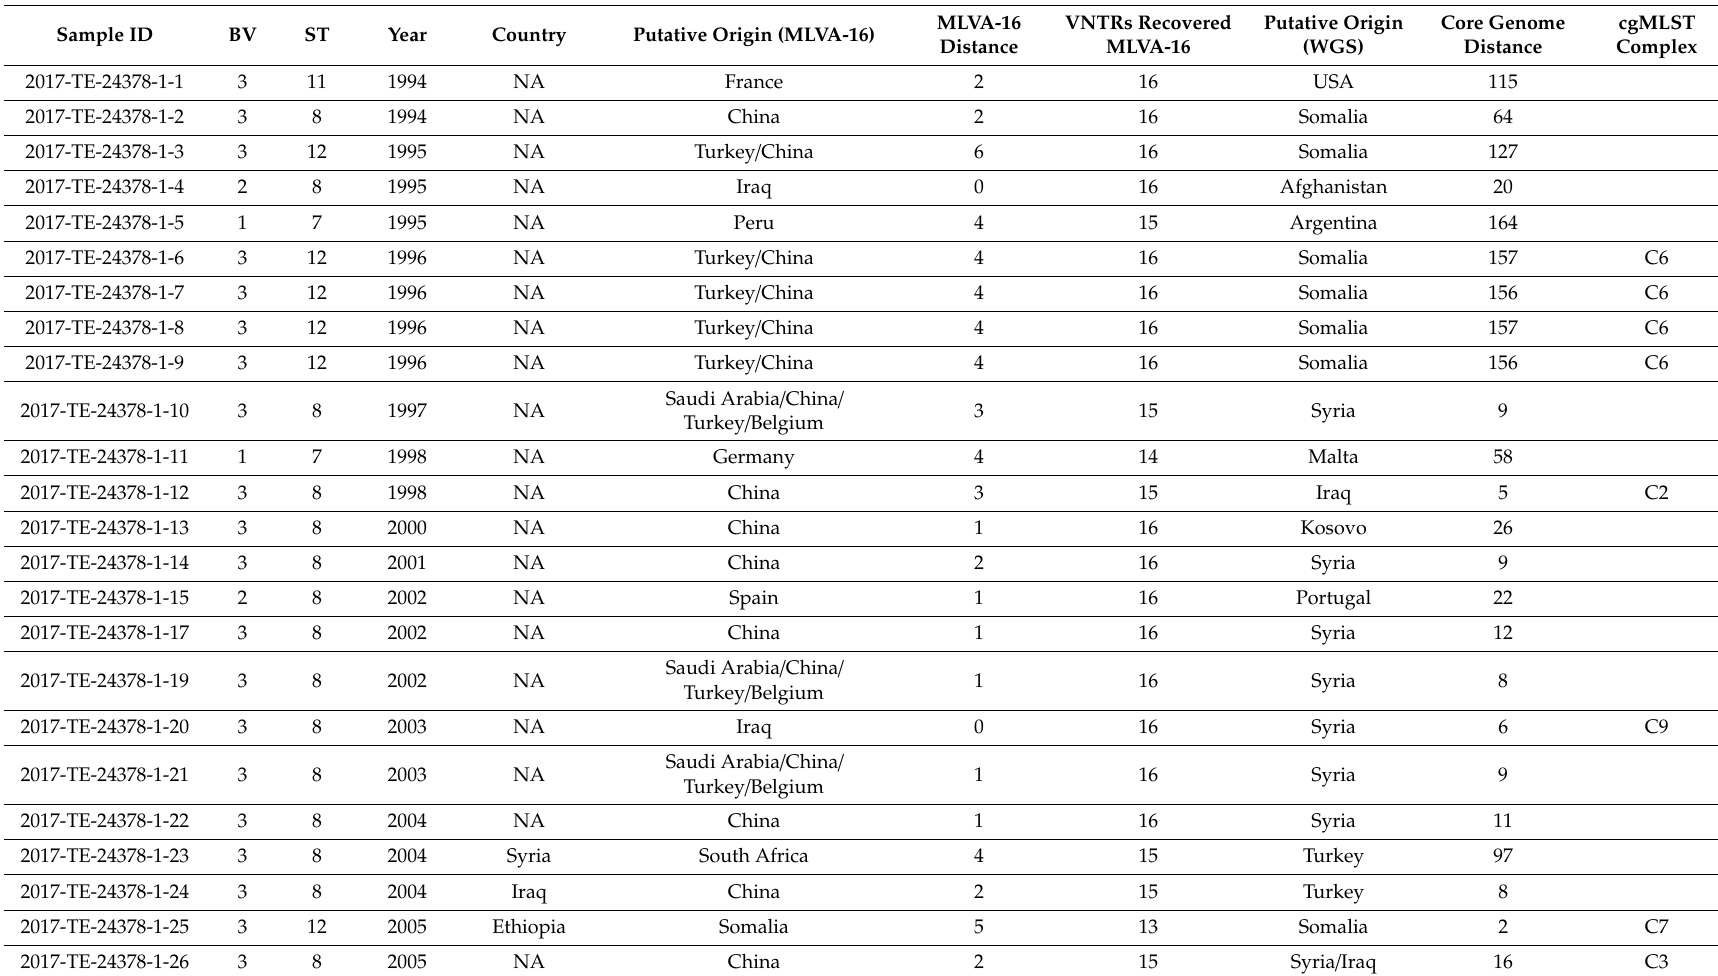
Table 1. B. melitensis isolates analyzed in this